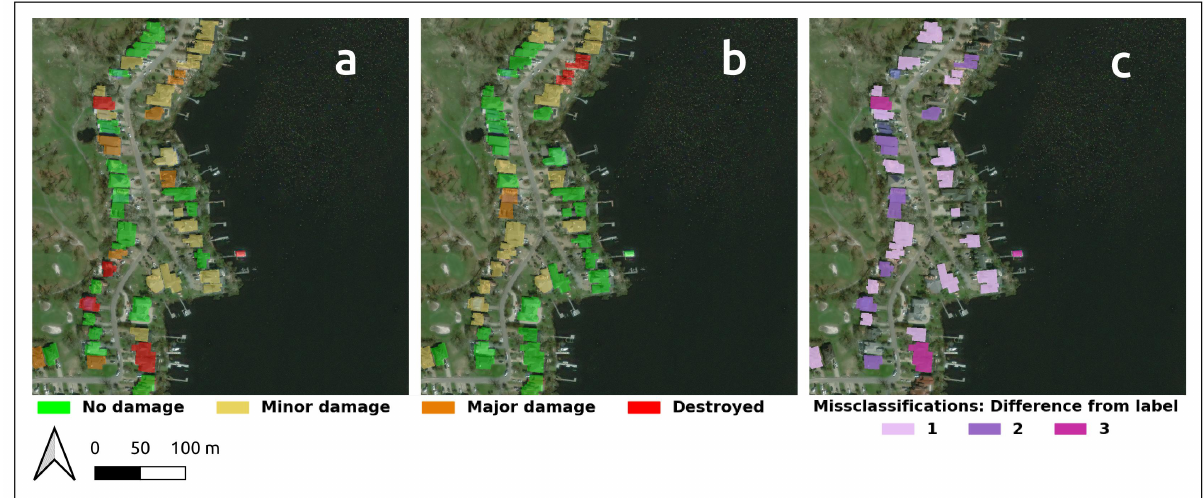
Figure 8. Application of ProtoNet model on a test case from Hurricane Michael. Satellite image overlaid with: ( a ) the predictions, ( b ) the labels and ( c ) the difference between the